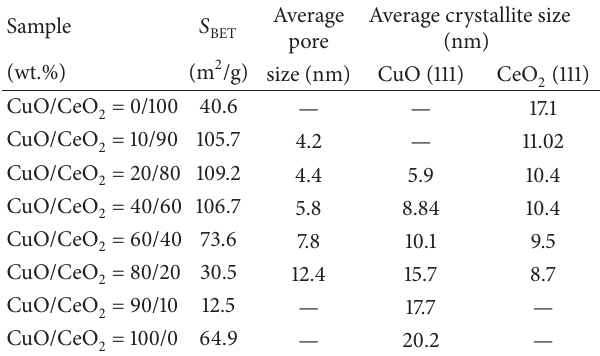
Table 1: Physical properties of the